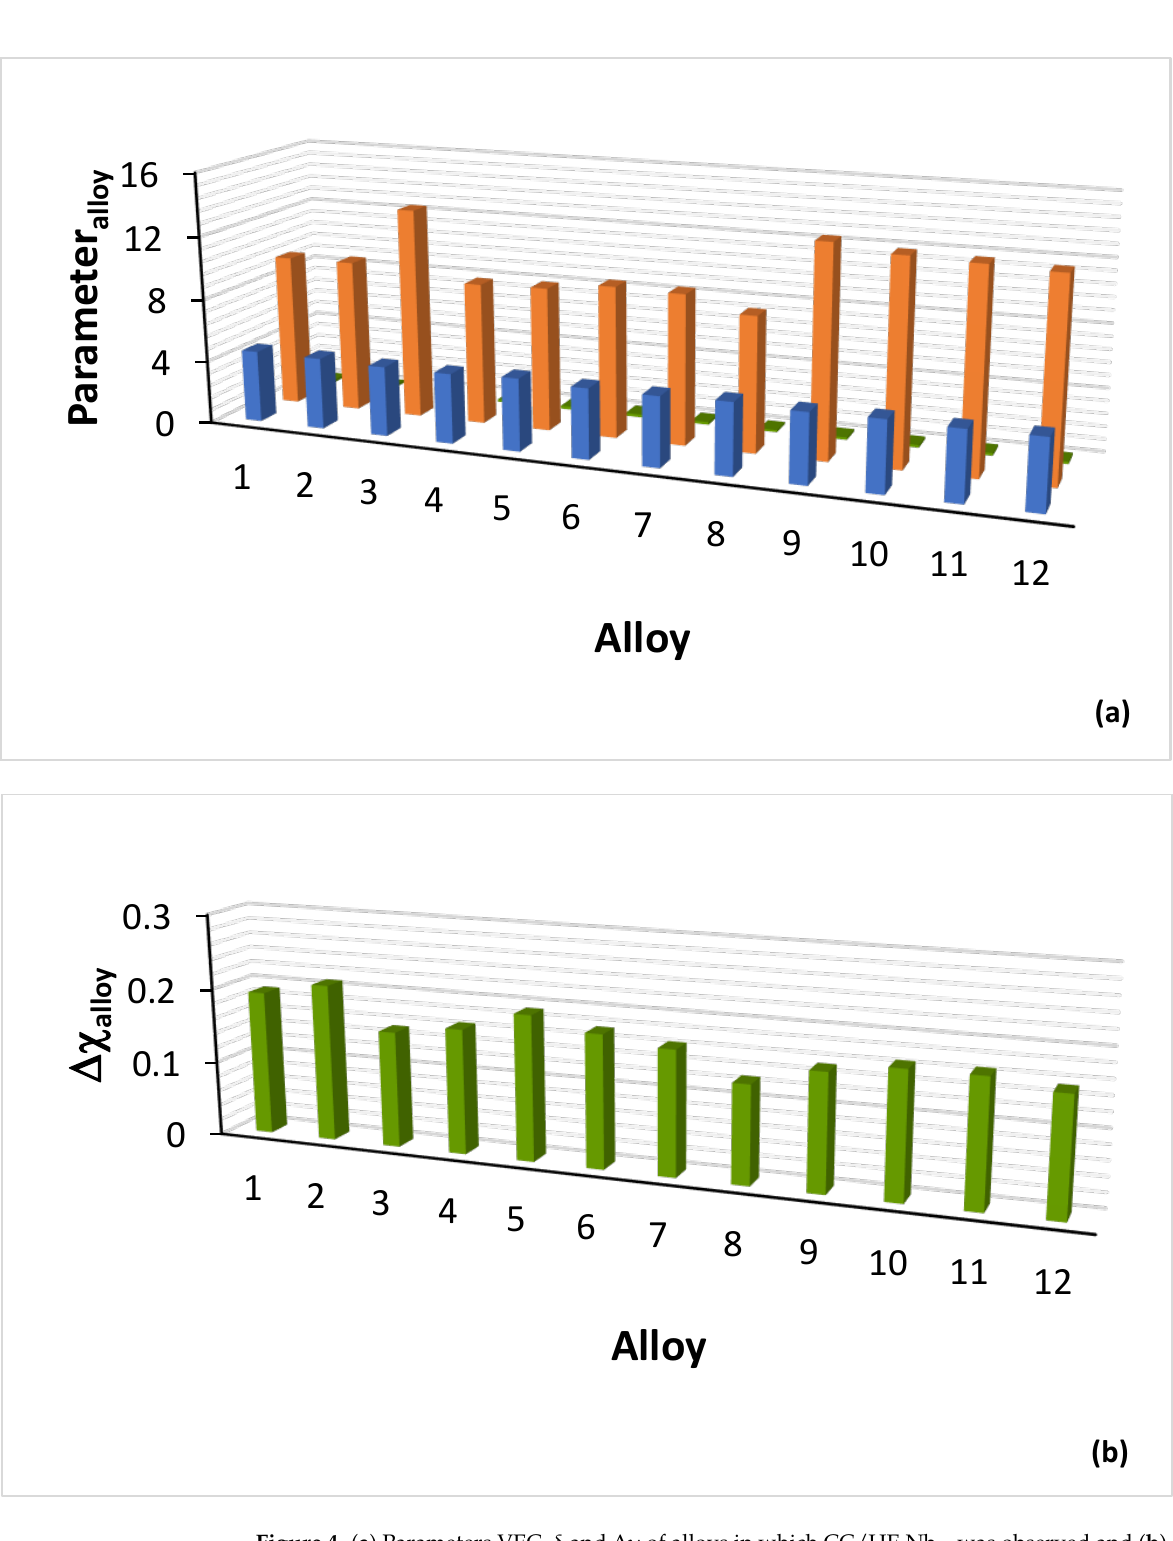
Figure 4. ( a ) Parameters VEC, δ and ∆ χ of alloys in which CC/HE Nb ss was observed and ( b ) details of ∆ χ alloy. Colours: blue VEC, brown δ , green ∆ χ . Alloys 1 to 12 contain Al, Cr, Nb, Si, Ti plus in (1) Ge, Hf, Sn, Ta, W, in (2) Ge, Hf, Mo, Sn, W, in (3) B, Ta, in (4) Ge, Hf, in (5) Ge, Hf, Sn, Ta, W, in (6) Hf, Mo, Sn, in (7) Hf, Sn, in (8) Ta, in (9) B, in (10), B, Mo, in (11) B, Hf, in (12) B, Ta. 1 = JZ3+-AC, 2 = JZ5-HT, 3 = TT5-AC, 4 = ZF9-AC, 5 = JZ3-AC, 6 = JG6-AC, 7 = EZ8-AC, 8 = KZ6-AC, 9 = TT4-AC, 10 = TT8-AC, 11 = TT7-AC, 12 = TT5-HT. For nominal alloy compositions and references see Appen- dix A. RM(Nb)ICs (5, 8 – 10) and RM(Nb)ICs/RCCAs (1 – 4,6,7,11,12).